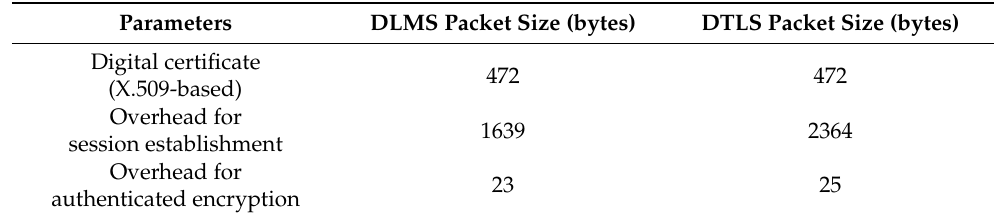
Table 8. Required packet size for